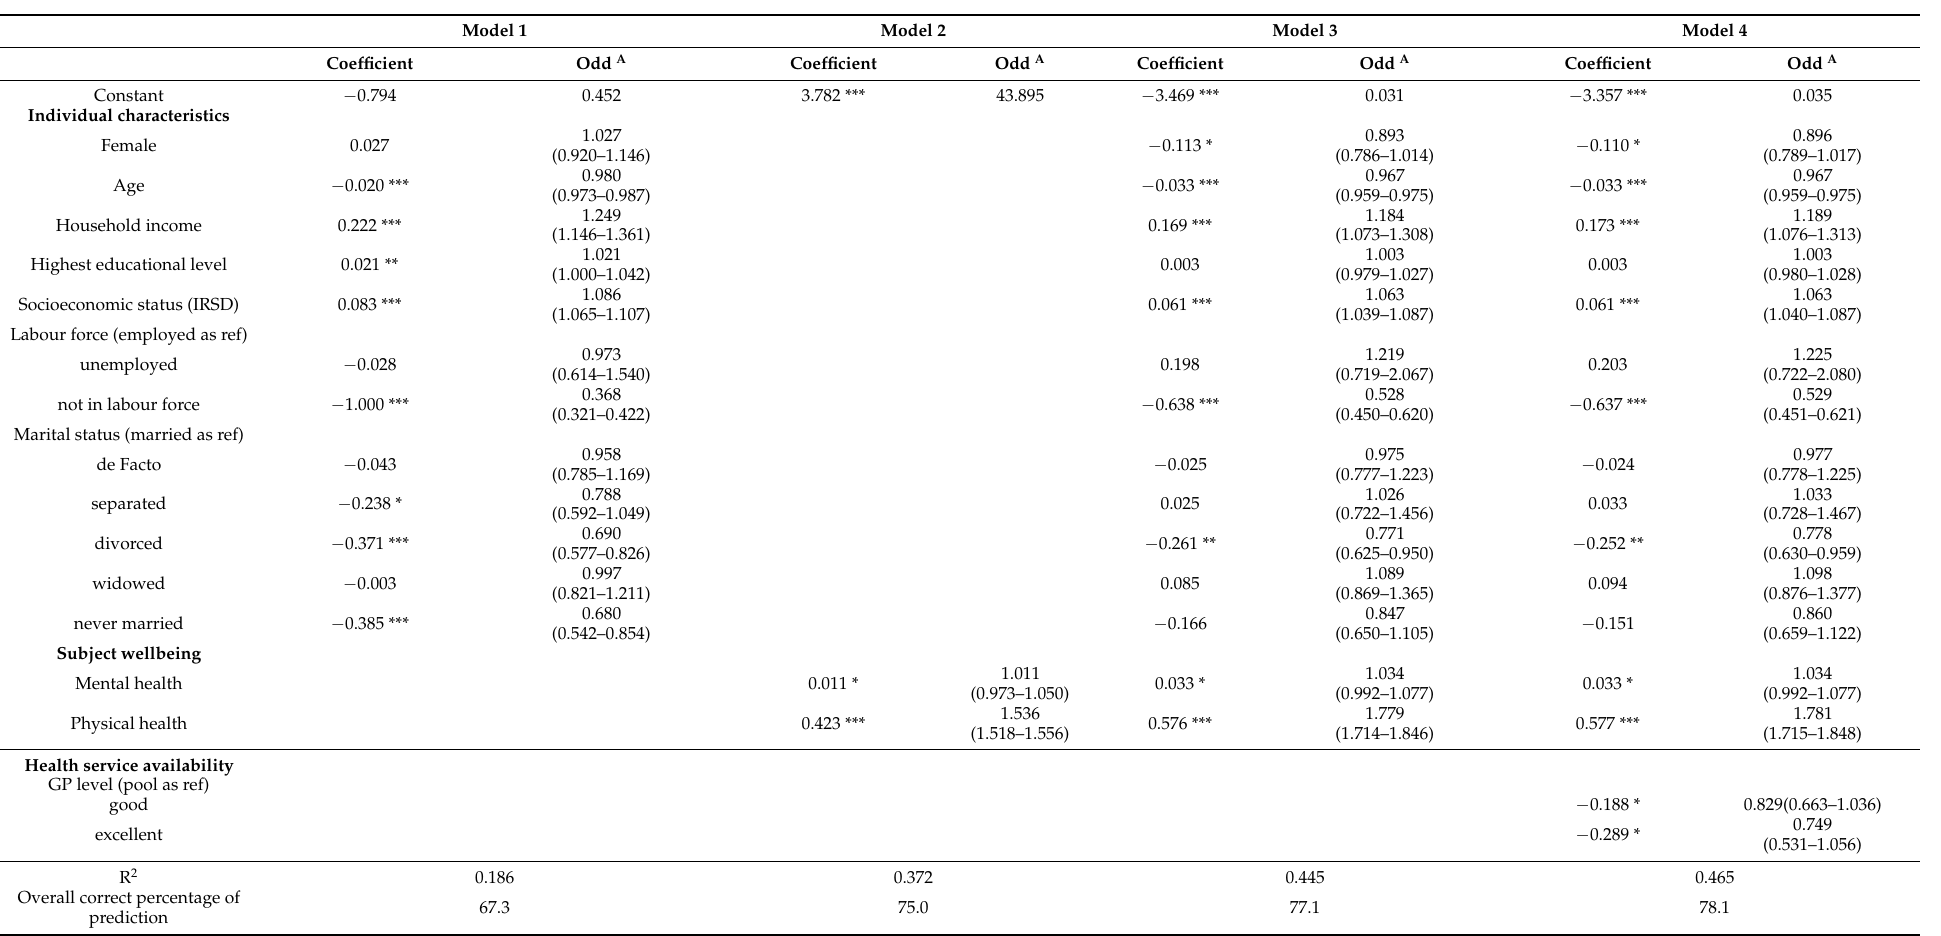
Table 3. Results of the binomial logistic